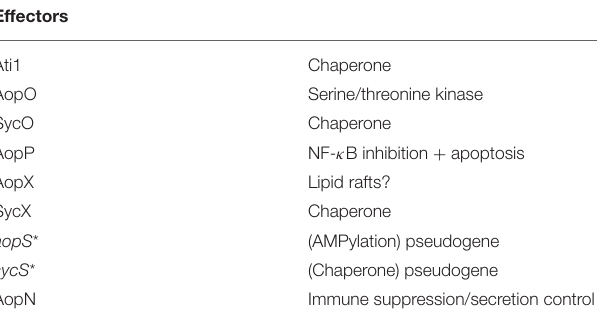
* refer to pseudo-genes that are not expressed.